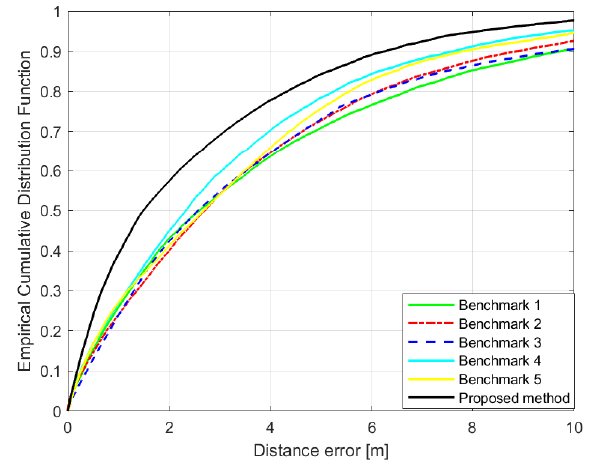
Figure 9. Regression results of the distance–RSS data with the proposed method.